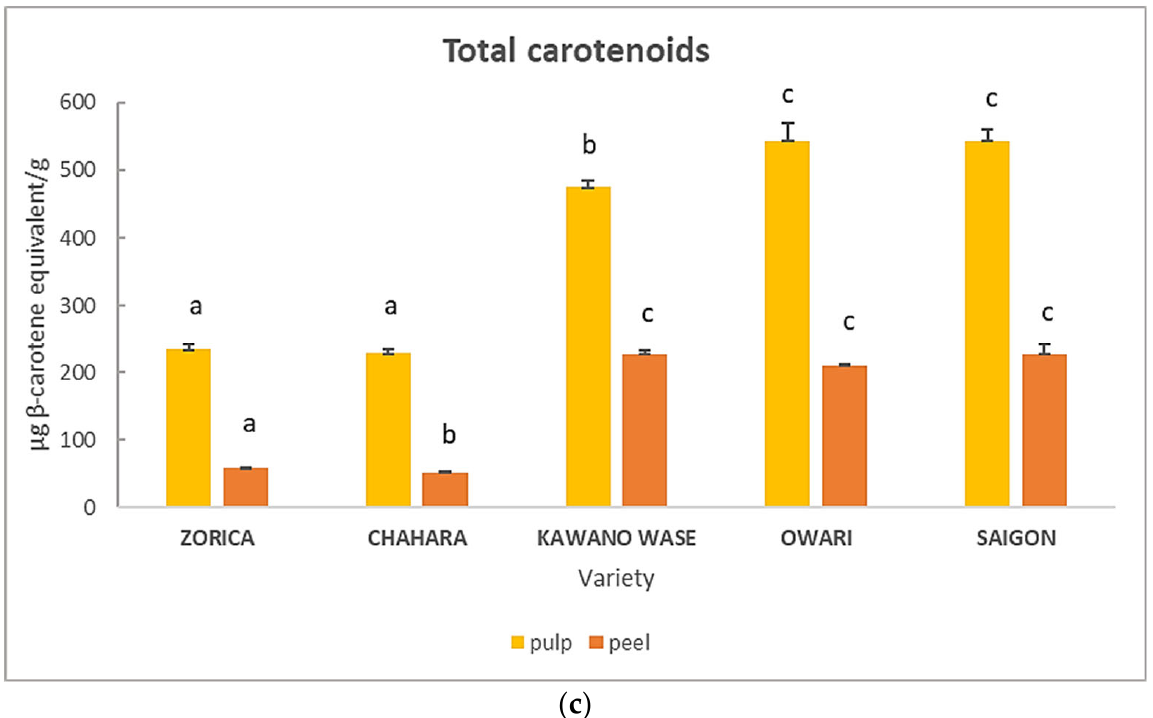
Figure 2. Bioactive compounds as ( a ) total polyphenolic compounds (TPC), ( b ) total flavonoids (TF) and ( c ) total carotenoids (TC) in dry pulp residue and dry peel of different mandarin varieties from Neretva valley (Croatia). Results are expressed per g of dry weight mandarin dry pulp residue/peel. The same letters above the same-colored bars are not significantly different according to the post hoc t -test with Bonferroni adjustment ( p < 0.05).